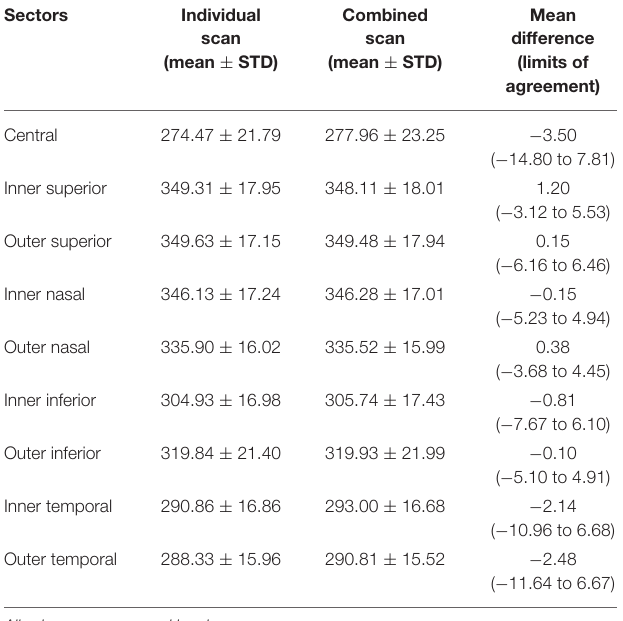
TABLE 2 | Retinal thickness in macula (Internal limiting membrane to retinal pigment epithelium) for 9 different sectors with two scan modes, and the agreement results.